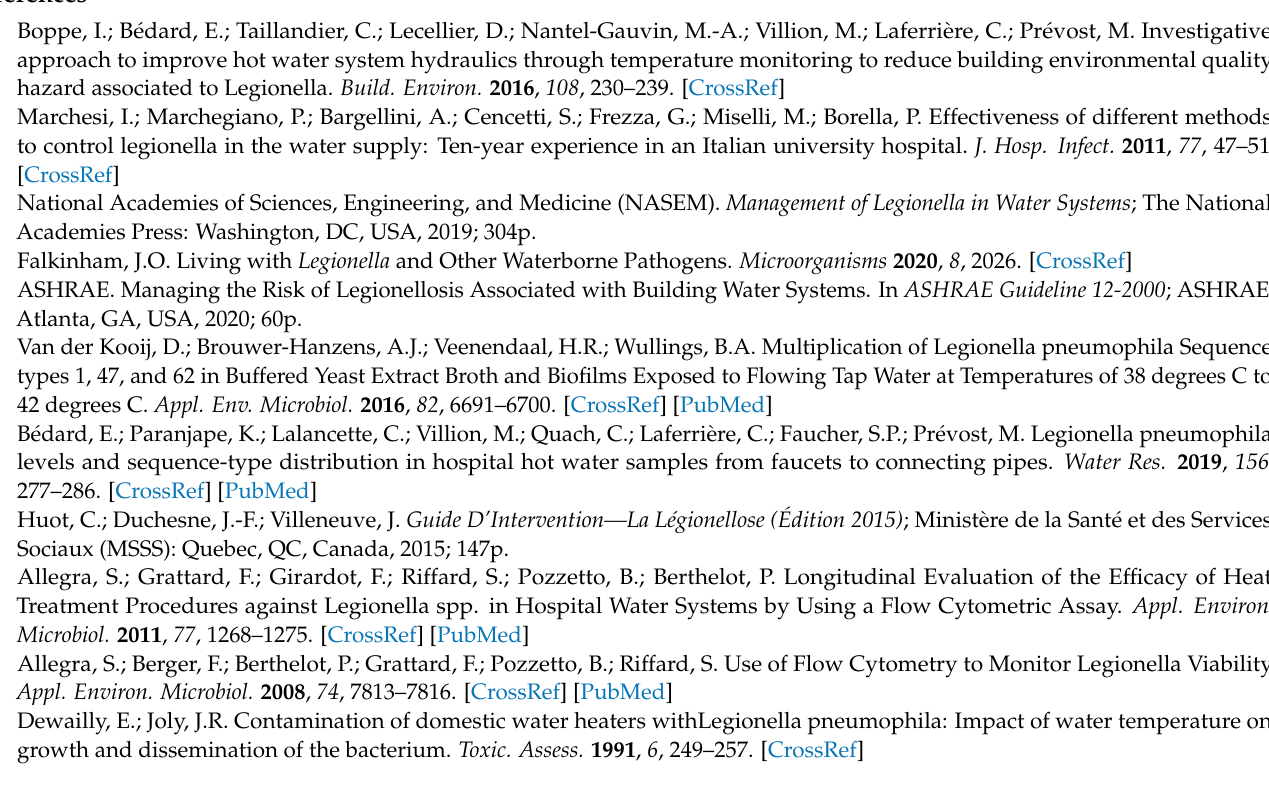
Table S2: Total populations of V. vermiformis estimated by microscopy after a 4 h-exposure at tempera- tures from 25 ◦ C to 60 ◦ C, Table S3: Mean values and standard deviations of the control samples